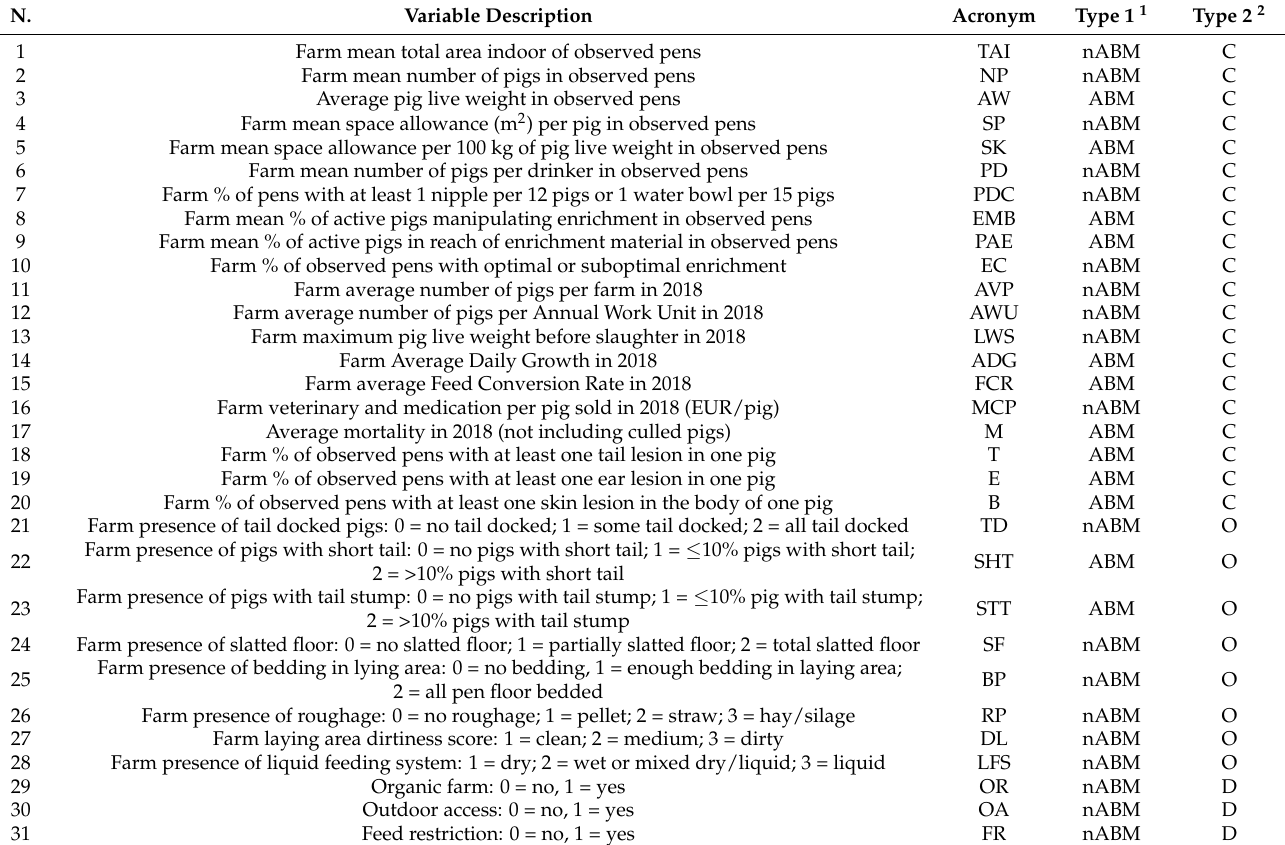
Table 2. Continuous, ordinal and dichotomous variables for 51 fattening pig units.